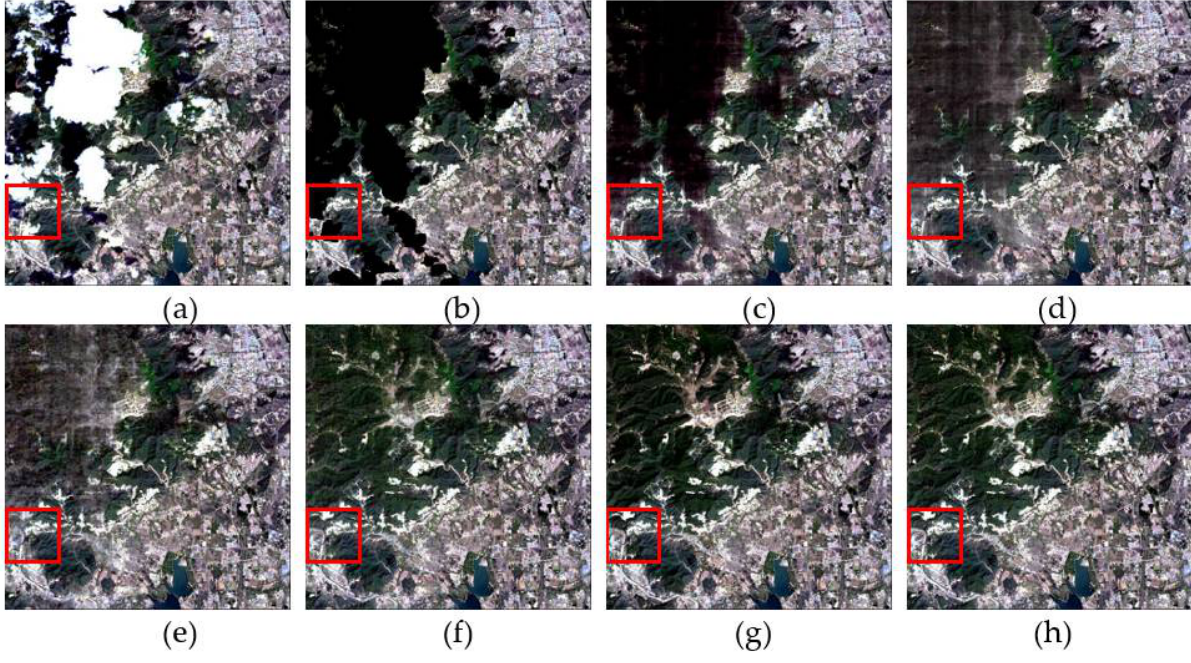
Figure 19. The real data experiment performed on dataset 7: ( a ) original image; ( b ) masked